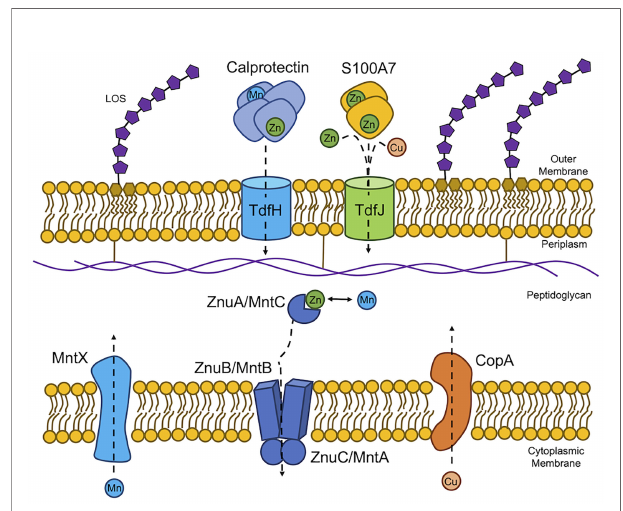
FIGURE 1 | Neisseria gonorrhoeae and Neisseria meningitidis experience host-driven nutritional immunity and metal intoxication. The host exerts nutritional immunity on the pathogenic Neisseriae by exposing the bacteria to calprotectin and S100A7. Calprotectin sequesters both zinc (Zn) and manganese (Mn) from the extracellular environment to limit Zn and Mn availability. N. gonorrhoeae in turn expresses TdfH, which has been shown to strip Zn from calprotectin and subsequently import the ion. TdfH is able bind Mn-loaded calprotectin suggesting a role for Mn import across the outer membrane. TdfH is referred to as CbpA in N. meningitidis. S100A7 also sequesters Zn from the extracellular environment. Gonococcal TdfJ binds S100A7 to pirate and import the Zn payload. Lipooligosaccharide (LOS) is shown in the outer membrane for reference. Once in the periplasm, Zn and Mn are chaperoned by the periplasmic binding protein, ZnuA (MntC) to the permease in the cytoplasmic membrane, ZnuB (MntB). Transport across the cytoplasmic membrane is energized by the ATPase, ZnuC (MntA). The host also exerts metal intoxication, speci fi cally copper (Cu) intoxication on N. gonorrhoeae and Mn intoxication in N. meningitidis through unknown mechanisms. In response, these ef fl ux proteins export excess cytoplasmic Cu or Mn from to the periplasmic